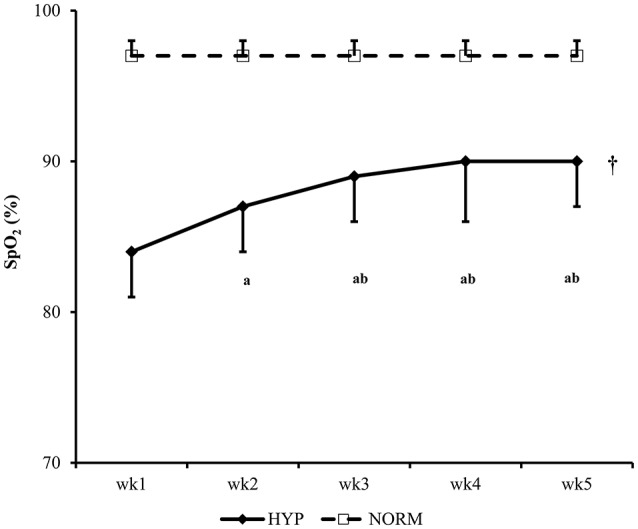
The changes in peripheral oxygen saturation (SpO2) of participants during the 5-wk HIIT under normoxia (NORM) and normobaric hypoxia (HYP) are shown [partial η2 = 0.849 (time); 0.823 (group); 0.780 (time × group)]. †Significantly different from the corresponding values of the NORM group (p < 0.05). aSignificantly different from the wk1 value of the HYP group (p < 0.05); bSignificantly different from the wk 2 value of the HYP group (p < 0.05); HIIT, high-intensity interval training.